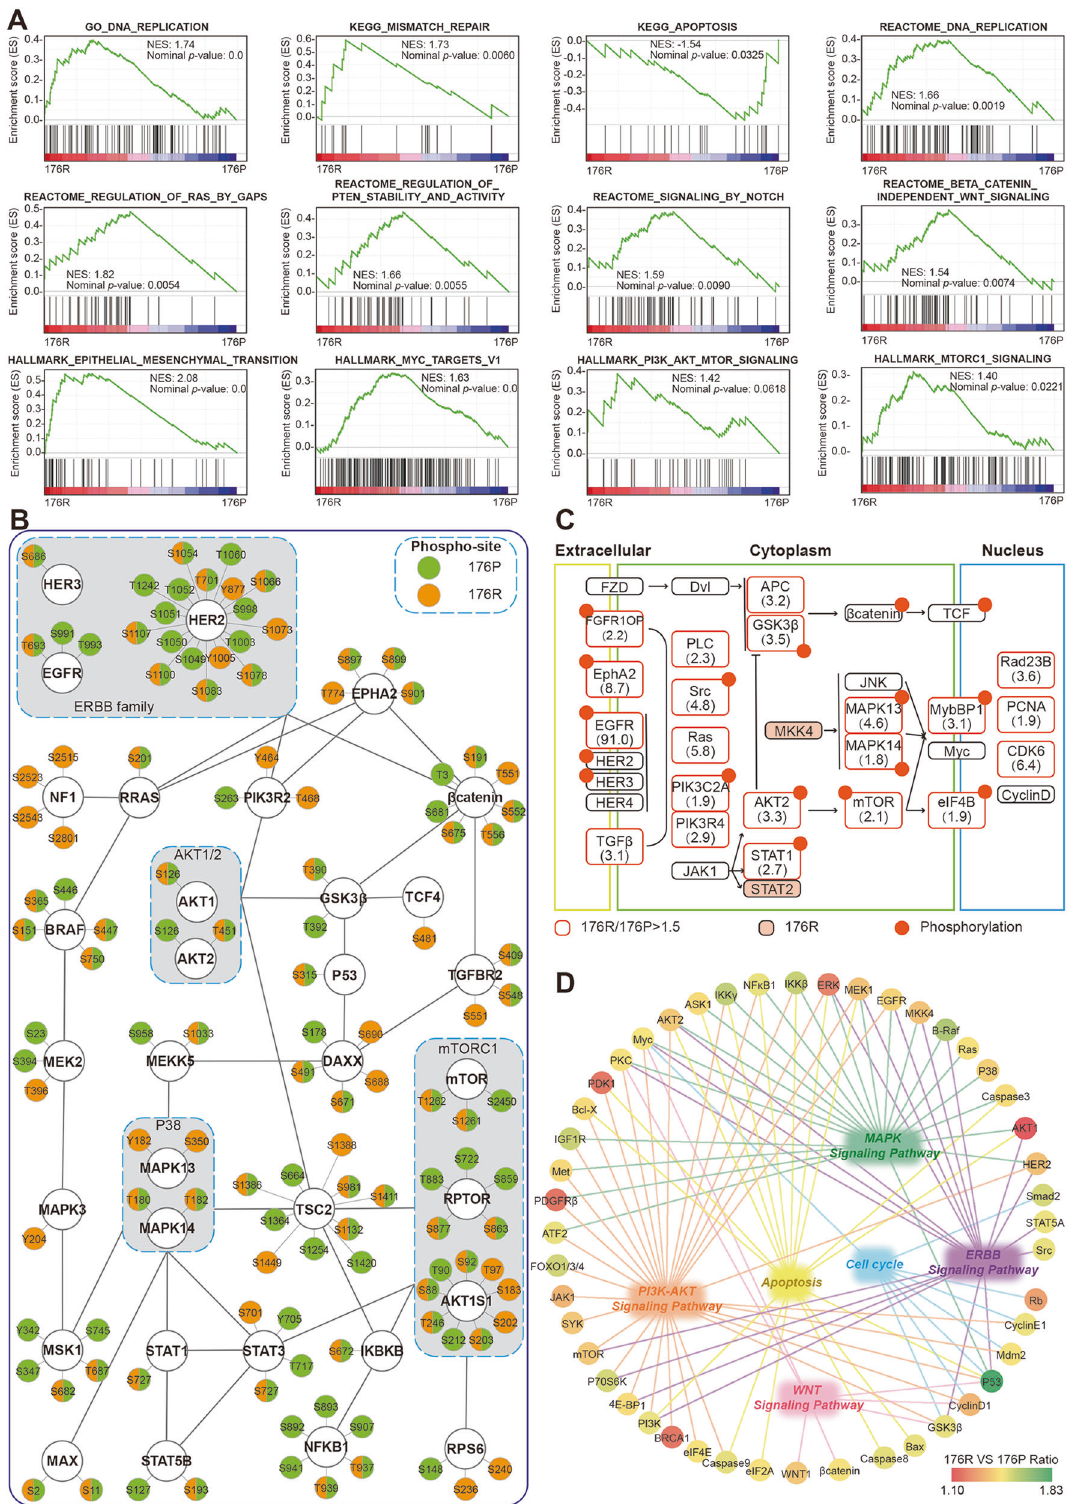
Fig. 5 Protein expression pro fi le and phosphorylation pro fi le in tissues before and after Trastuzumab resistance. A The total 2983 proteins expressed both in 176P and 176R tissues were enriched according to GO, KEGG, REACTOME, and HALLMARK datasets, by GSEA. NES: Normalized Enrichment Score. B Phosphorylation pro fi les of some important molecules identi fi ed by protein chip. C The upregulated and phosphorylated proteins were distributed in various signaling pathways after Trastuzumab resistance by proteomic analysis. D The upregulated proteins found by protein chip were involved in several critical pathways including MAPK, PI3K/AKT, WNT pathways, and so on.